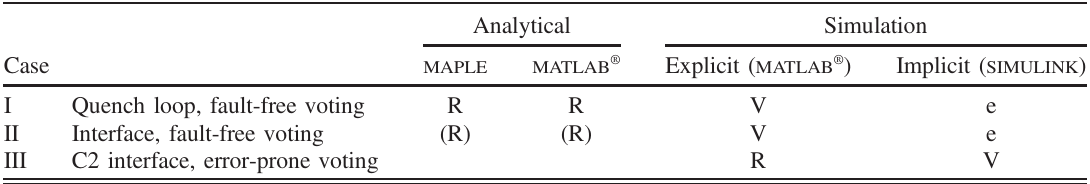
TABLE III. Implementations underlying results (R) and verification (V). Extra implementation (e).